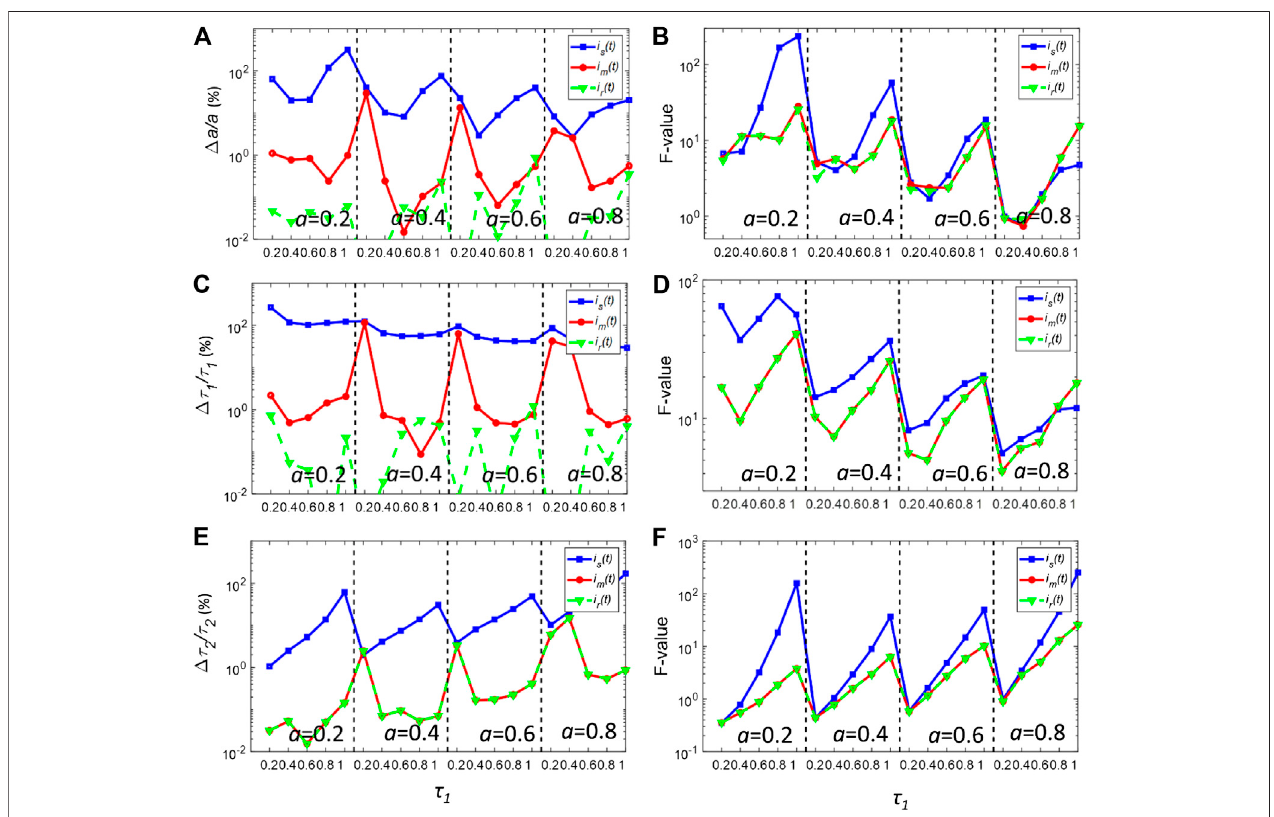
FIGURE 3 | (A,C,E) normalized bias plots for a , τ 1 and τ 2 when N c (cid:2) 10 6 . The corresponding F -value plots are depicted in (B,D,F) .